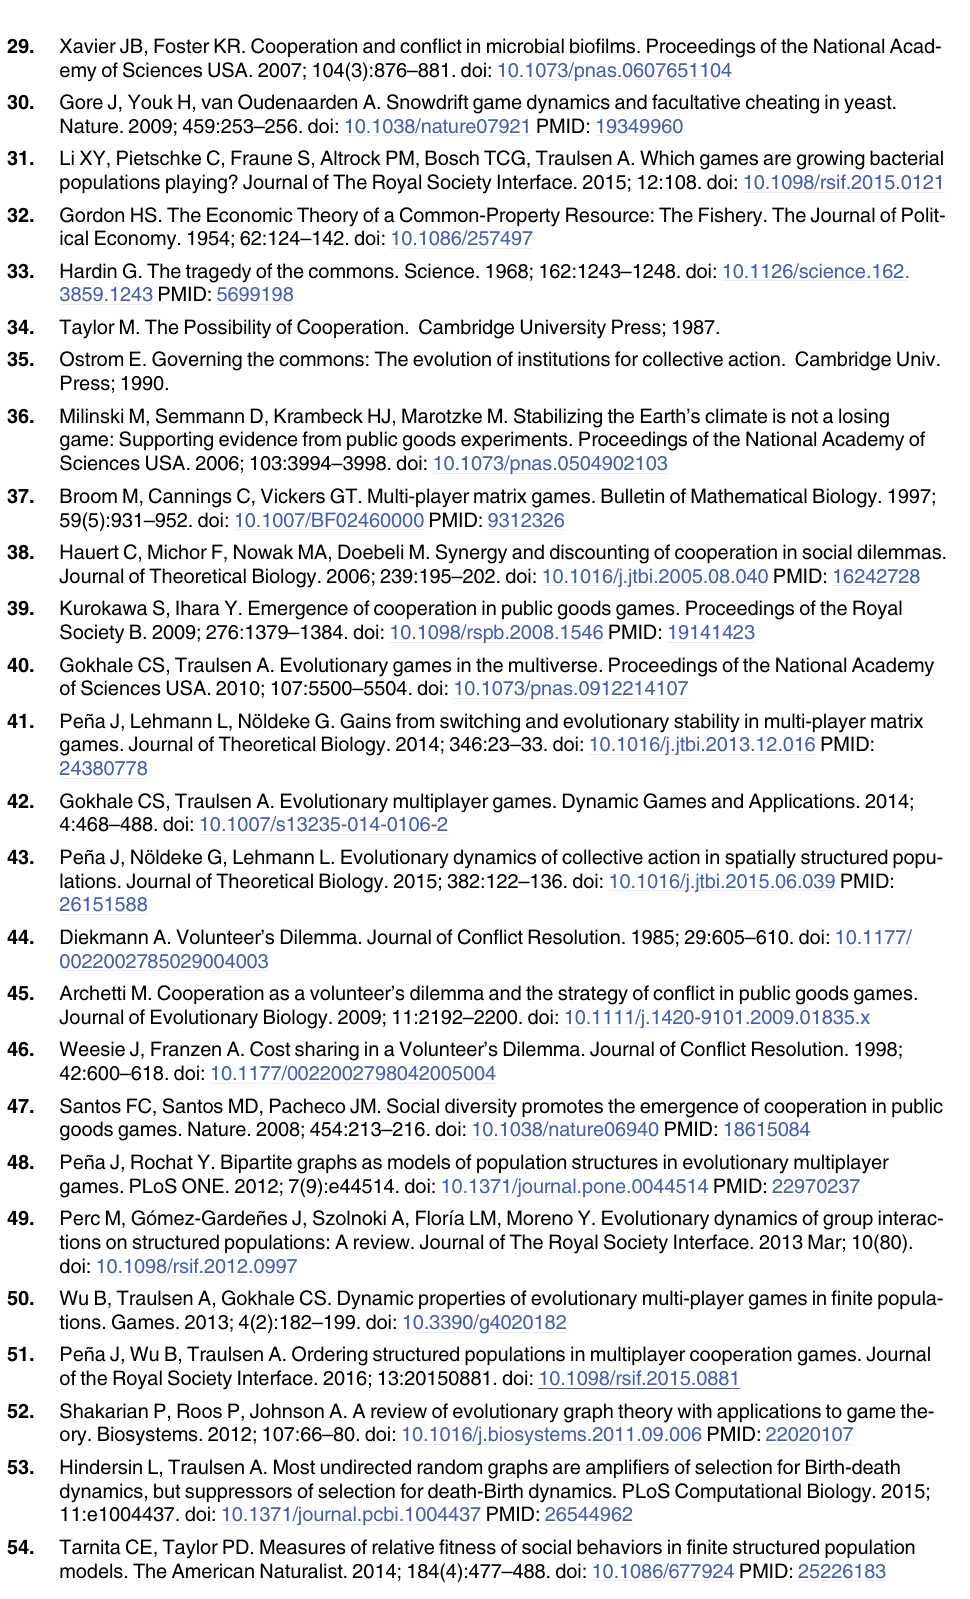
PLOS Computational Biology | DOI:10.1371/journal.pcbi.1005059 August 11,